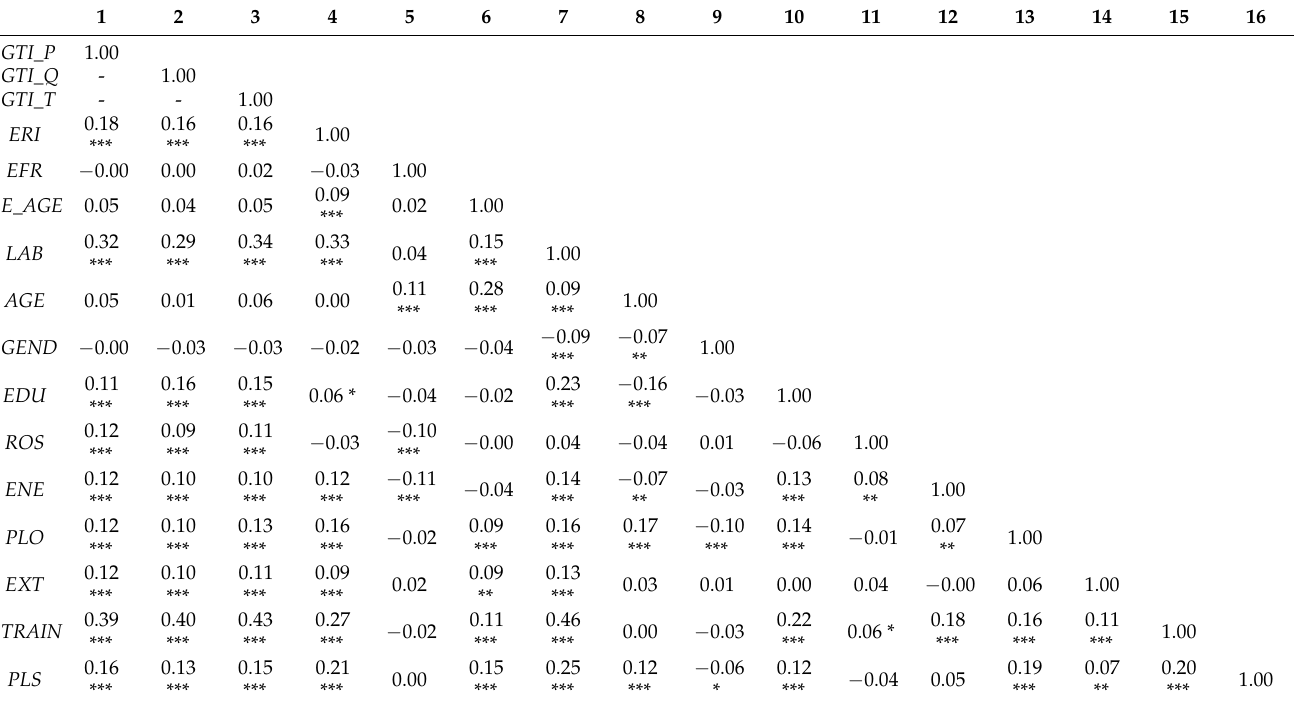
Table 2. Correlation coefficient of main